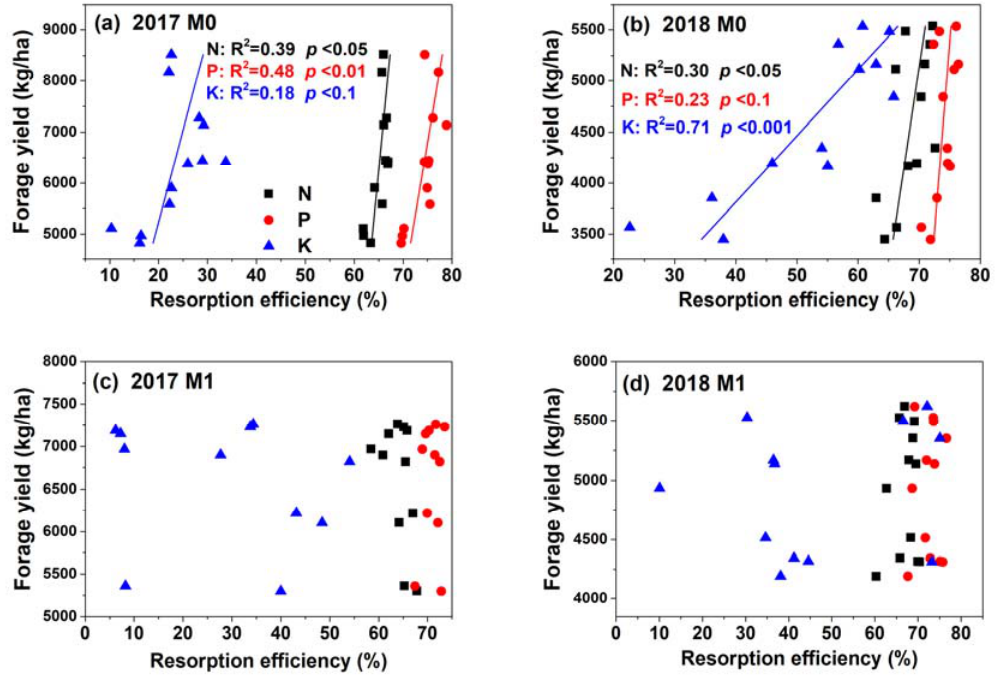
Figure 6. Relationships between N, P, and K resorption efficiencies and alfalfa forage yield in the ( a, b ) no ‐ mulch treatment (M0) and ( c, d ) mulched treatment (M1) in ( a, c ) 2017 and ( b, d ) 2018.